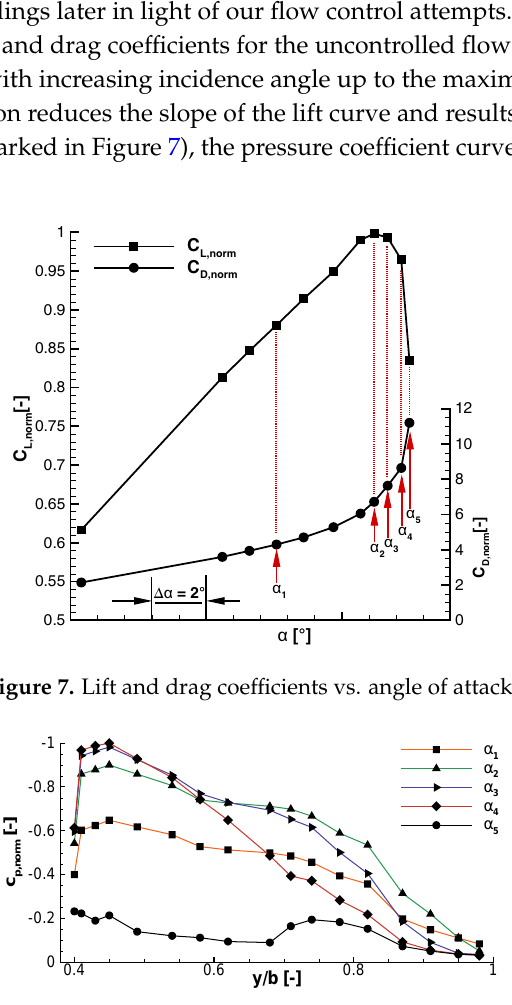
Figure 8. Pressure coefficient curve in the spanwise direction for various incidence